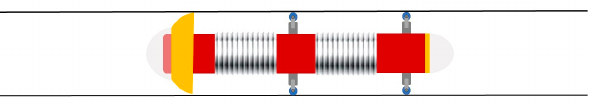
Figure 1. In-pipe detection robot.